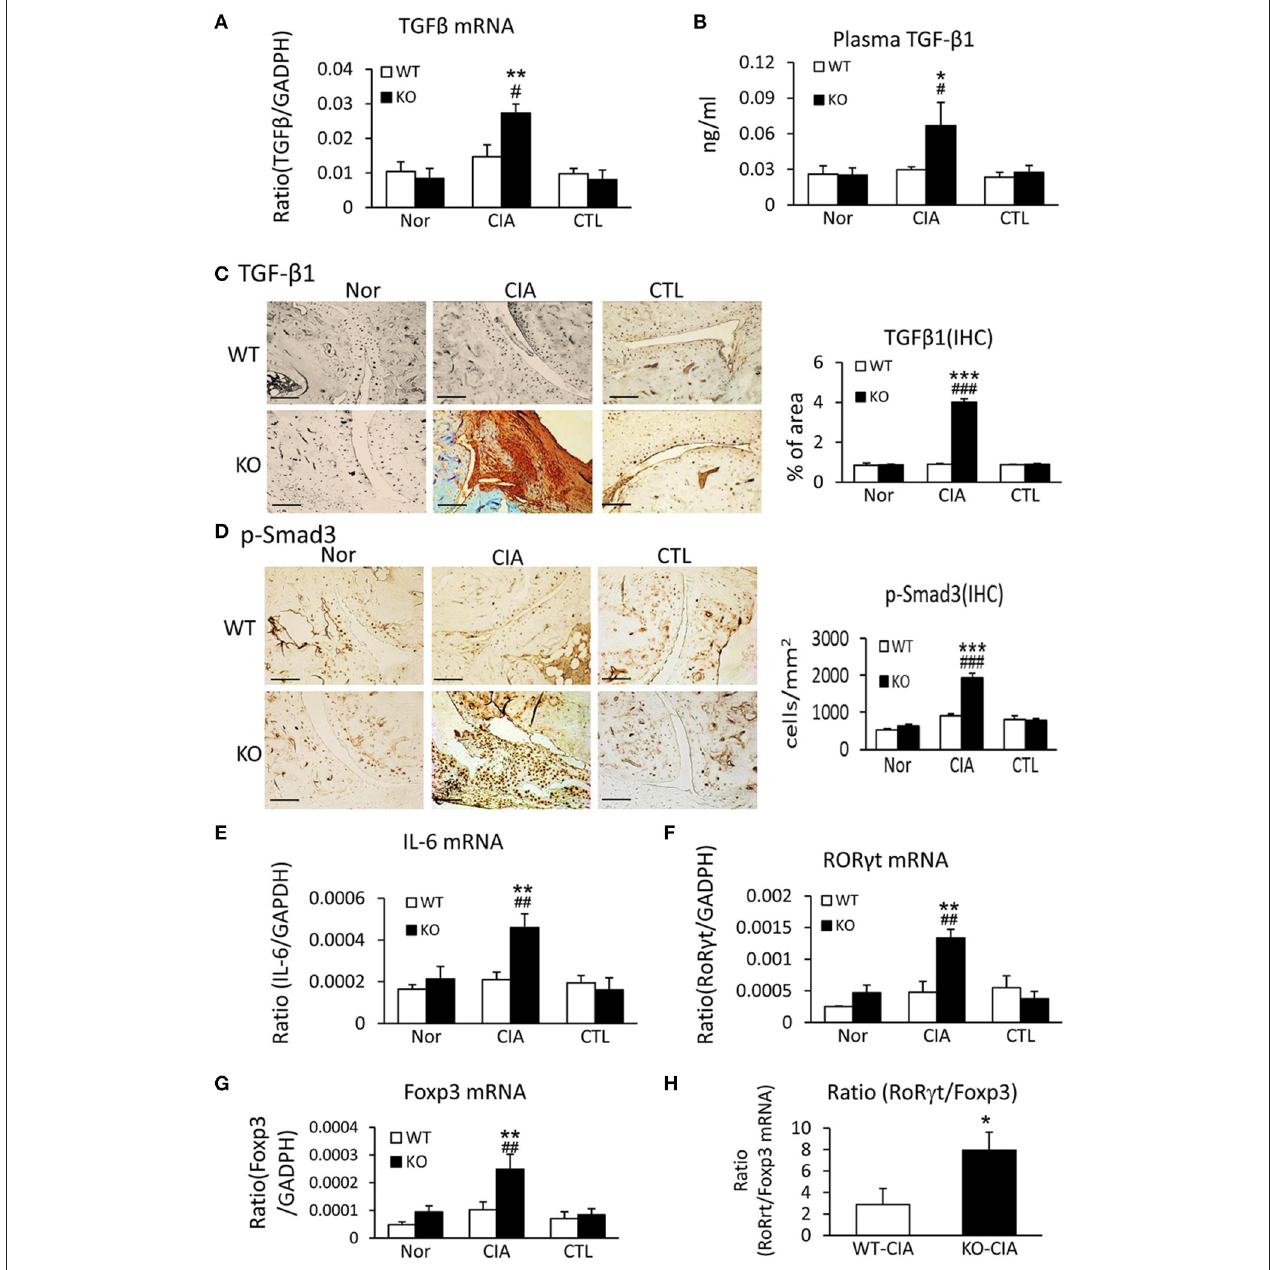
FIGURE 6 | Deletion of Smad7 enhances TGF- β 1/Smad3 and IL-6 signaling and promotes Th17 over the Treg responsein the synovial tissues of CIA in CD-1 mice. (A) Synovial TGF- β 1 mRNA expression by real-time PCR. (B) Plasmalevels of TGF- β 1 by ELISA. (C) Synovial IL-6 mRNA expression by real-time PCR. (D) Synovial ROR γ t mRNA expression by real-time PCR. (E) Synovial TGF- β 1 expression by immunohistochemistry. (F) Activation of Smad3 signaling identified by phospho-Smad3 (p-Smad3) nuclear translocation. (G) Synovial Foxp3 mRNA expression by real-time PCR. (H) Ratio of synovial ROR γ t/Foxp3 mRNA expression. Data are expressed as mean ± S.E. for group of 8 mice. * p < 0.05, ** p < 0.01, *** p < 0.001 vs. control (CTL); # p < 0.05, ## p < 0.01, ### p < 0.001 vs. WT-CIA group. Scale bar, 50 µ